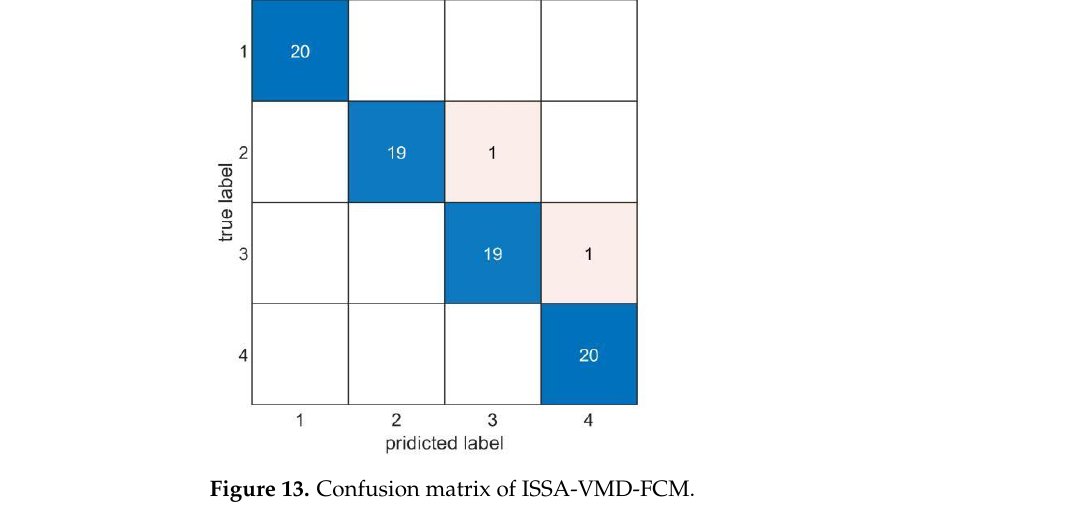
Figure 13. Confusion matrix of ISSA-VMD-FCM. Table 5. Average accuracy of different